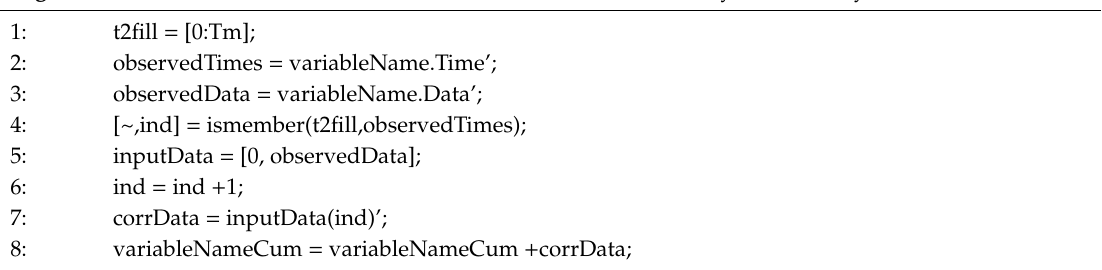
Table A5. Attributes (or Properties) of the basic events.